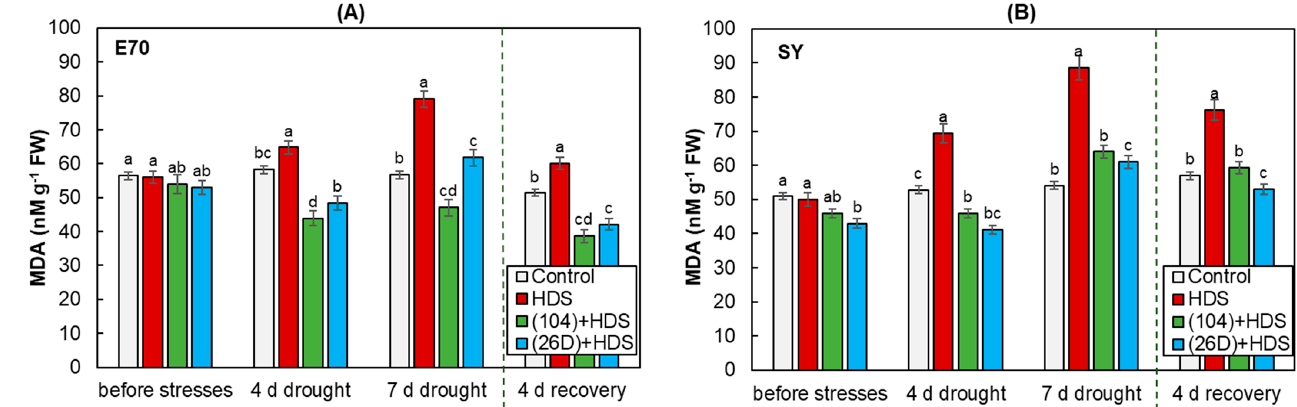
Figure 7. Influence of B. subtilis 104 and 26D on malondialdehyde (MDA) concentration in spring wheat varieties E70 ( A ) and SY ( B ) under combined herbicide + drought stress (HDS), as well as in the post-stress period (4 days of recovery). Error bars represent standard errors (±SE). Various letters show a significant difference between the averages of different groups at p < 0.05.